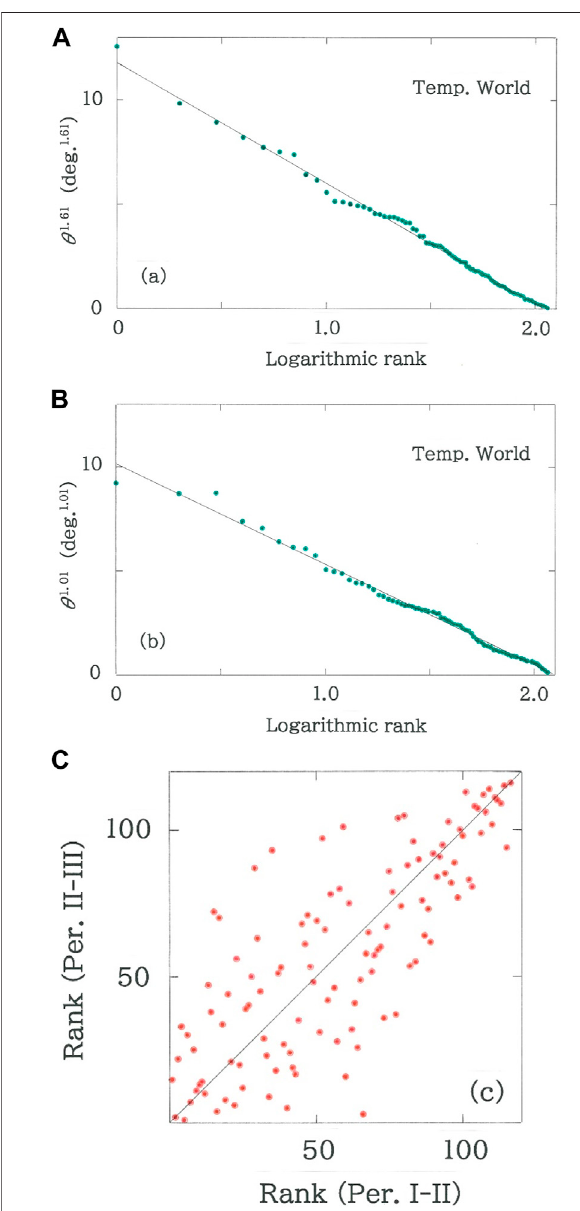
FIGURE 3 | Rank dependence of the cross angles of the monthly temperatures on the World stations ( Supplementary Tables S1,S2 in Supplementary Material). (A) From Period I (from 1931 to 1960) to Period II (from 1951to1980). The lineindicatestheoptimized fi t(| r | (cid:1) 0.9974 with d (cid:1) 0.594 for q (cid:1) 1.61 and n (cid:1) 115). (B) From Period II (from 1951 to 1980) to Period III (from 1981 to 2010). The line in the plots indicates the optimized fi t (| r | (cid:1) 0.9961 with d (cid:1)